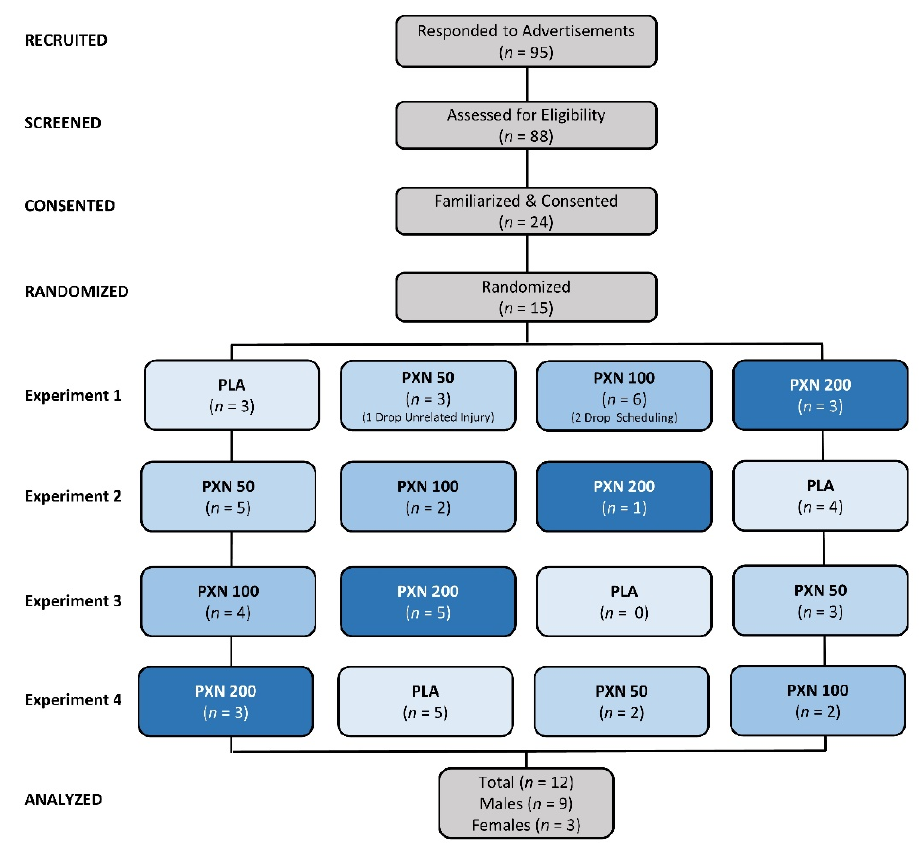
Figure 1. Consolidated Standards of Reporting Trials (CONSORT) diagram for the placebo (PLA) and paraxanthine (PXN) treatments.